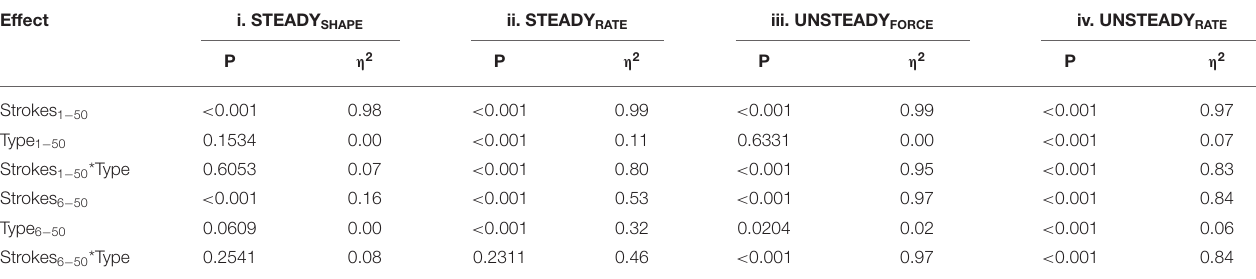
TABLE 3 | P -values and effect sizes for fixed effects (stroke, type and the interaction of stroke*type) of differences in mechanical power output between the reference system of a test rig for air-braked rowing ergometers and the Concept 2 Indoor Rower’s PM5 Monitor within steady and unsteady experiments. Effect